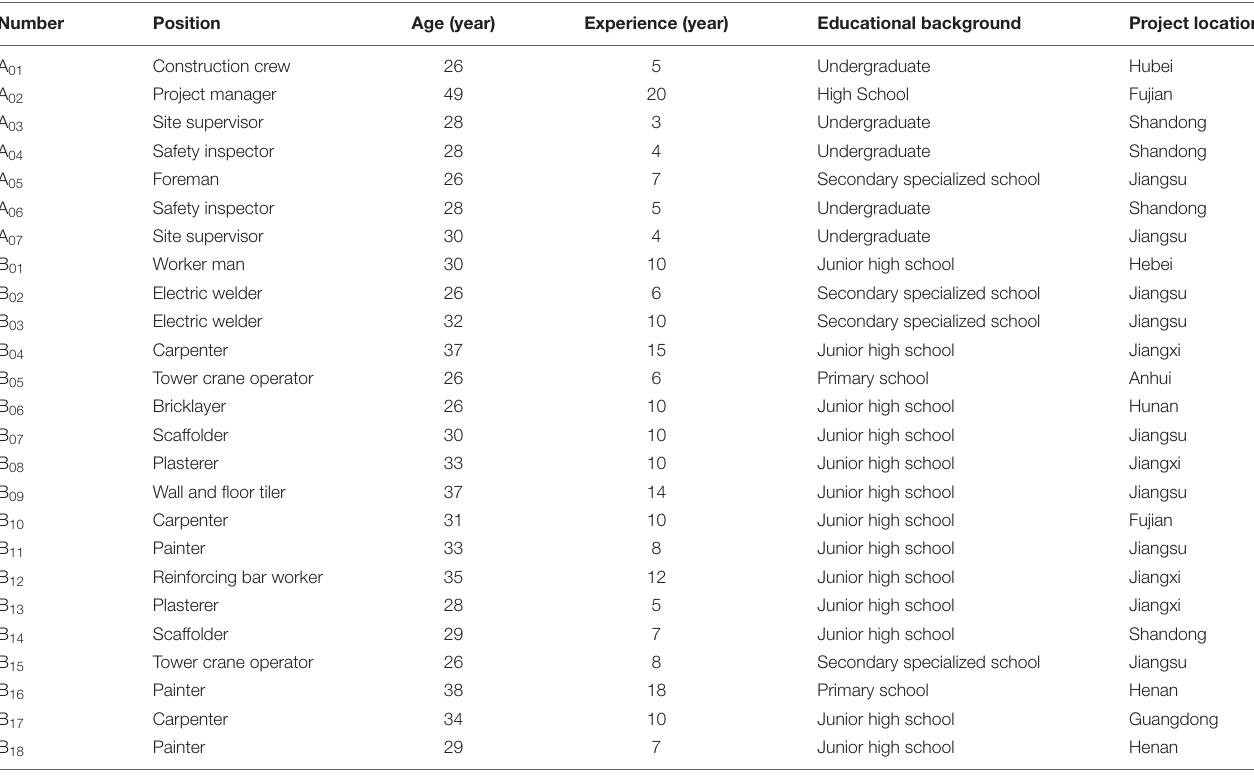
TABLE 1 | Basic information of